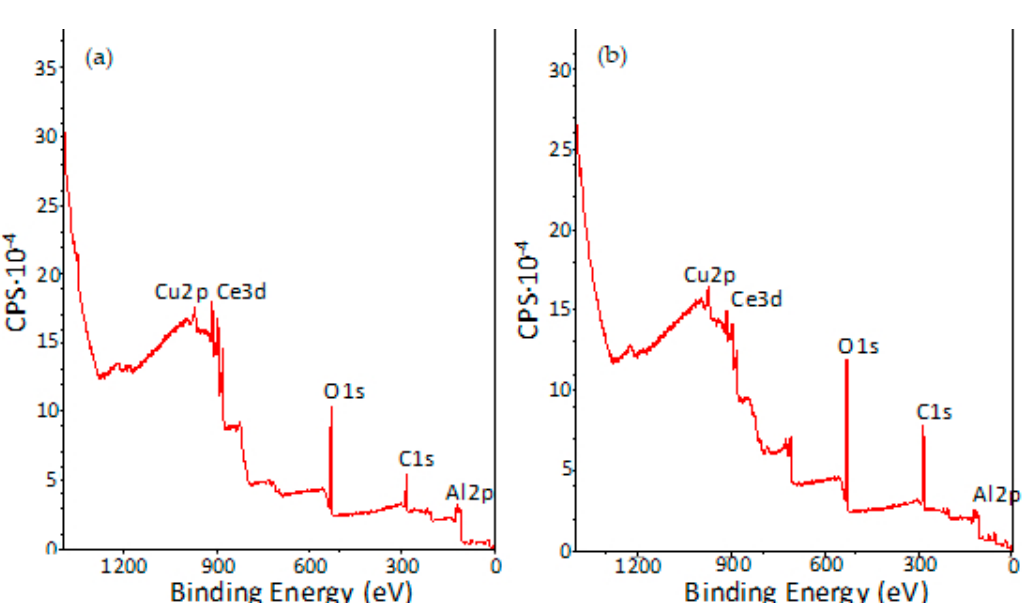
Figure 12. Survey X-ray photoelectron spectroscopy (XPS) spectra of ( a ) CeCC-1 and ( b ) CeCC-2. Table 4. Surface composition of samples CeCC-1 and CeCC-2 (at. %).